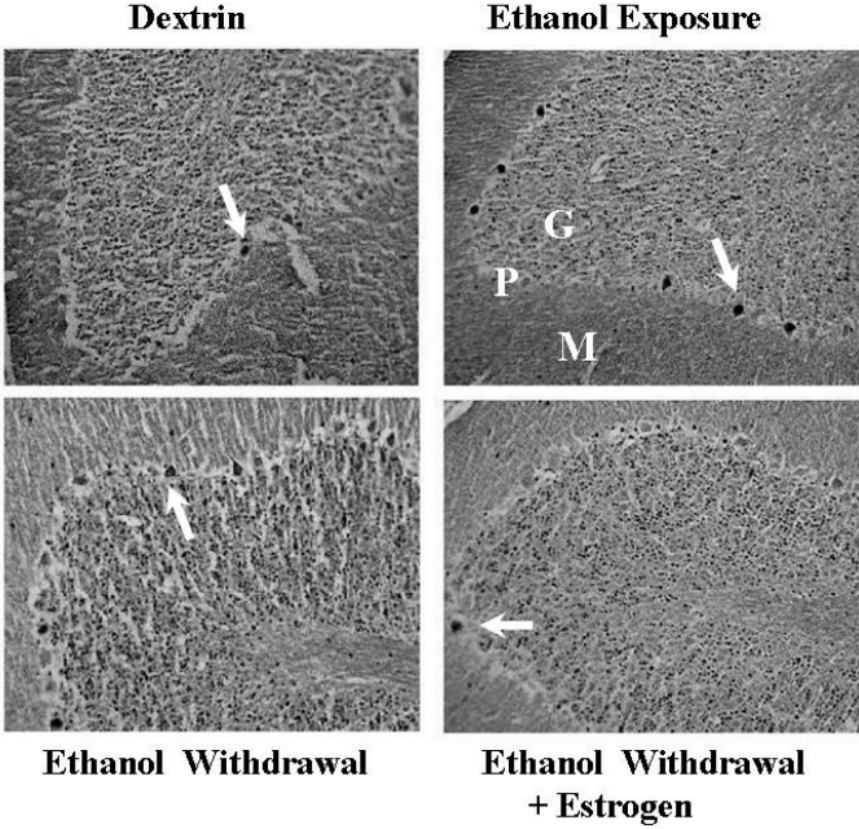
Figure 3. Immunohistochemical detection of pP38 expression in the cerebellum. Ovariectomized rats implanted with oil pellets or E2 pellets began a 25-day-ethanol (6.5%) and 5-day-withdrawal, repeating 3 times. The ethanol-exposure group continuously received an ethanol-diet until the very end of a diet program and was gradually withdrawn. At the 14th day of the last EW, the left hemisphere containing the cerebellar vermis was processed for immunohistochemical analysis to locate pP38 protein. Dark deposits marked with arrows indicate pP38 positive neurons or cells in the Purkinje (P) and granular (G) layers. A magnification of a 20-fold was used to take pictures. A scale bar indicates an actual length of 200 µ